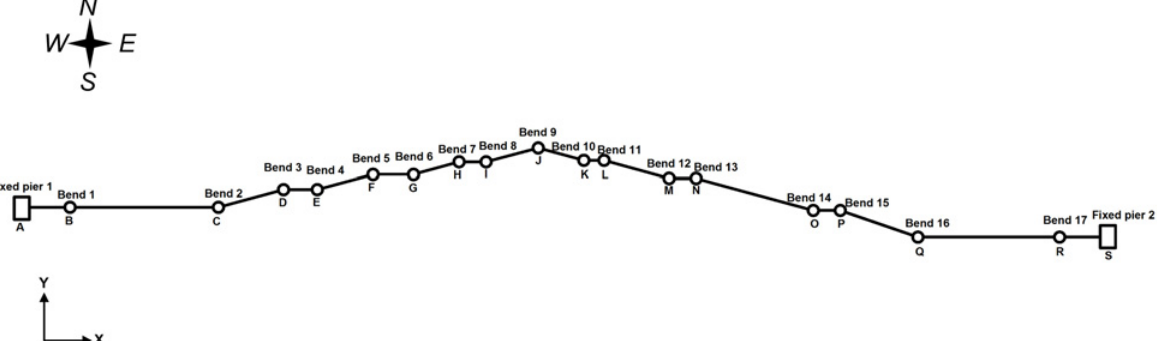
Fig 15. "Ladder" pipe laying schematic model.